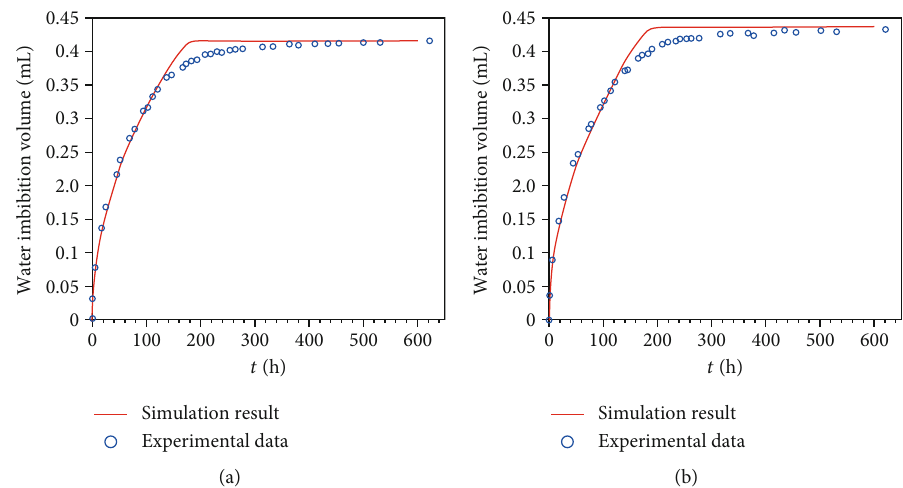
Figure 1: The variation of water imbibition volume with time. (a) Sample A. (b) Sample B (the weight is converted to volume by ρ 3 ). w = 1 : 0g/cm